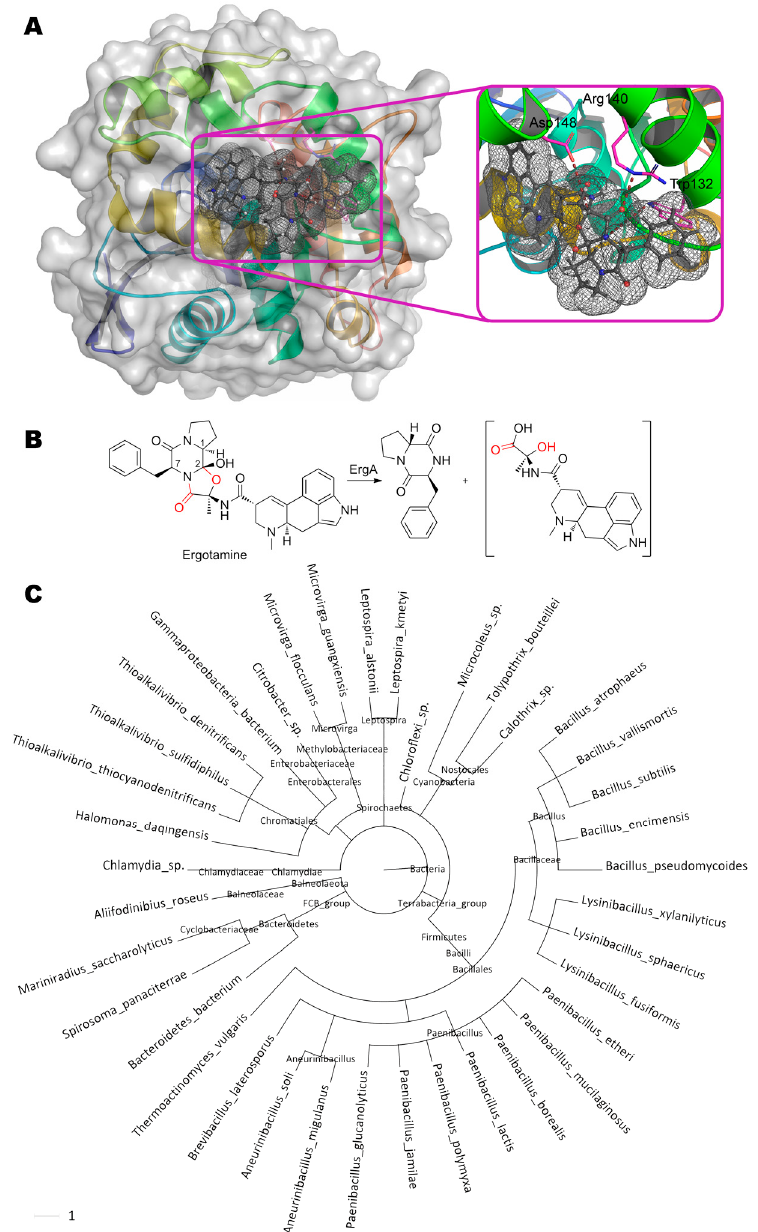
Figure 10. ( A ) Structure of enzyme ErgA containing ergotamine in its active center, and ( B ) scheme of substrate conversion with ErgA. Amino acid sequence was obtained from [132] and folded as described early. Position and geometry of substrate binding was determined as described early. ( C ) Phylogenetic tree of microorganisms possessing homologous enzymes found with BLAST.